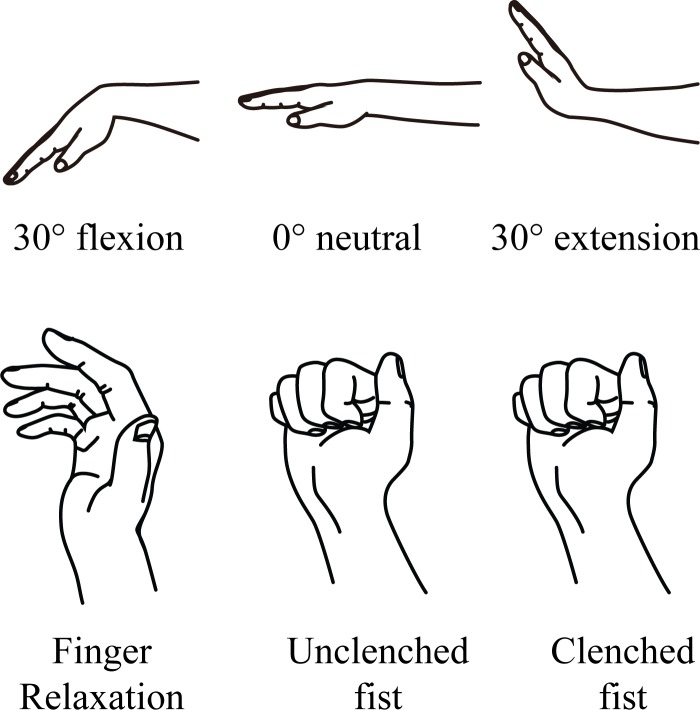
Grip conditions and wrist angles for ultrasound examination.Finger relaxation, the fingers are rest in natural curvature; Unclenched fist, full fingers flexion and hold with minimal effort; Clenched fist, full fingers flexion and exert force to grip.